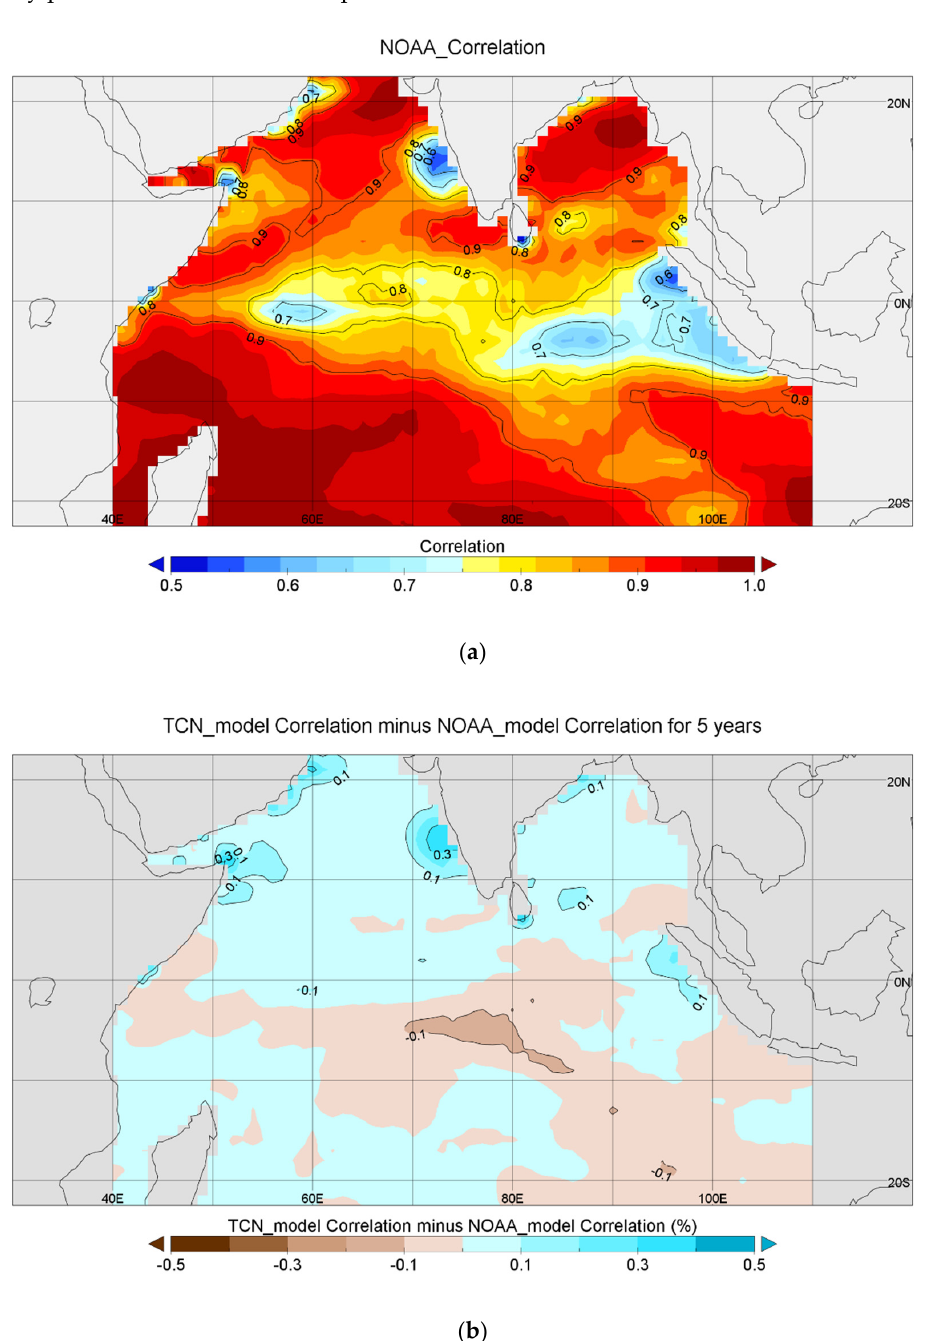
Figure 6. ( a ) Correlation between the Climate Forecast System version 2 (CFSv2) model-predicted SST time series and the actual SST time series. ( b ) The correlation of each point of TCN model minus the correlation of the corresponding points of